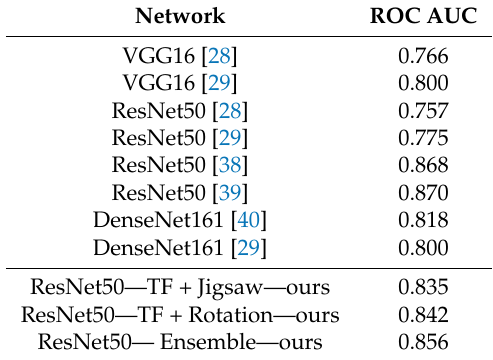
Table 9. Comparison with other works on the ISIC 2017